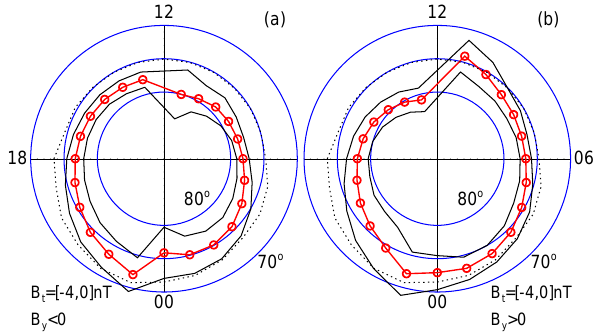
Figure 6. Typical location of the convection reversal boundary (CRB) in the MLT-MLAT coordinates, red circles, for IMF B z < 0, B t = [− 4 , 0 ] nT, and (a) IMF B y < 0 and (b) B y > 0. Monthly av- eraged SuperDARN convection maps for 1995–2013 were consid- ered. Shown by the solid line is the CRB location ± 1 standard de- viation from the inferred typical location.